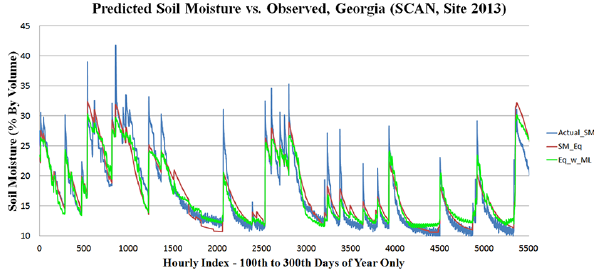
Figure 3. Soil moisture time series, SCAN site 2015, New Mex- ico (USA), actual soil moisture (blue line), diagnostic soil moisture equation estimate (red line), and diagnostic soil moisture equation with machine learning error correction (green line). Hydroclimate: IAQ (intermediate seasonality, arid, summer peak runoff). Soil tex- ture: loamy sand.